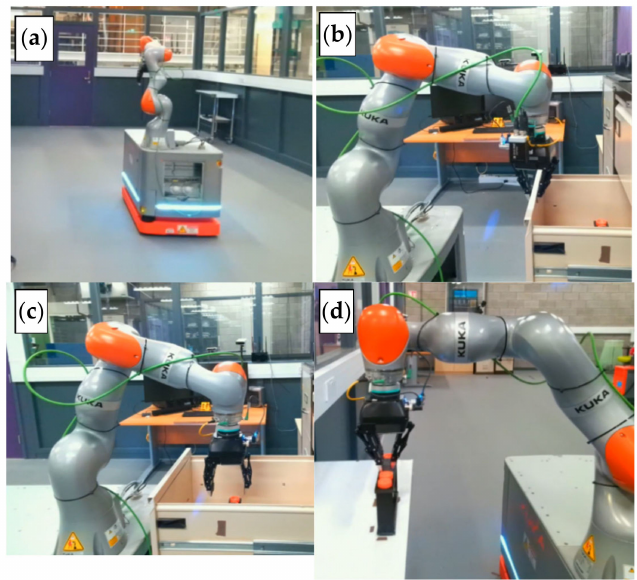
Figure 4. Different steps of the experiment showing the robot doing tasks ( a ) Moving to the storage area ( b ) Opening the storage ( c ) Picking the tray containing centrifugal tubes ( d ) placing the tray on the material transfer